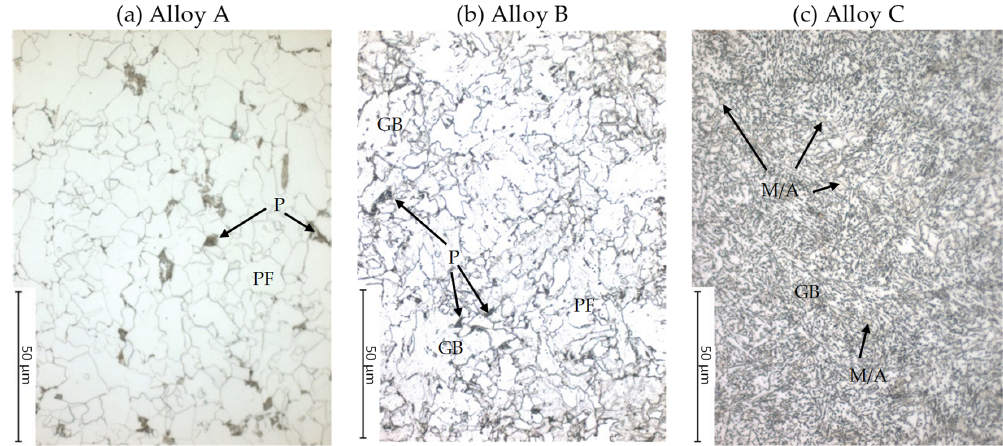
Figure 2. As-received microstructures of alloys A, B and Figure 2. As ‐ received microstructures of alloys A, B and C.